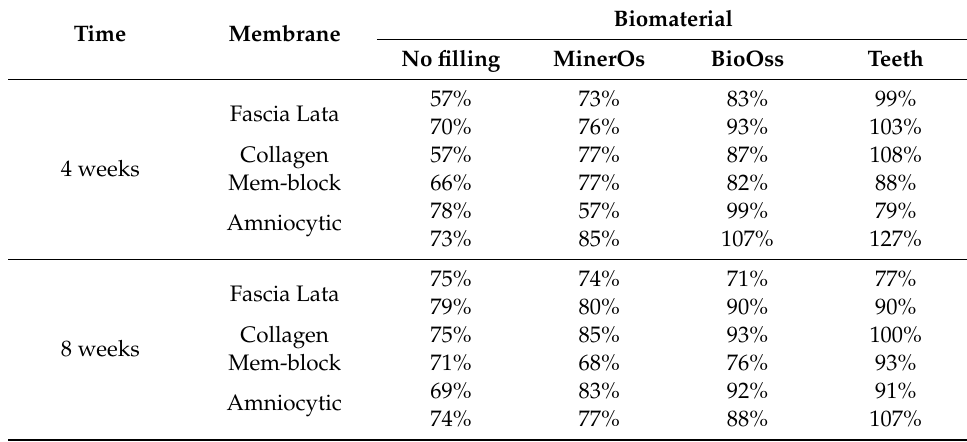
Table 1. The relative radiological density percentages recorded at 4 and 8 weeks according to the membrane type and graft filling (red tones express low percentages of radiological density and green tones high